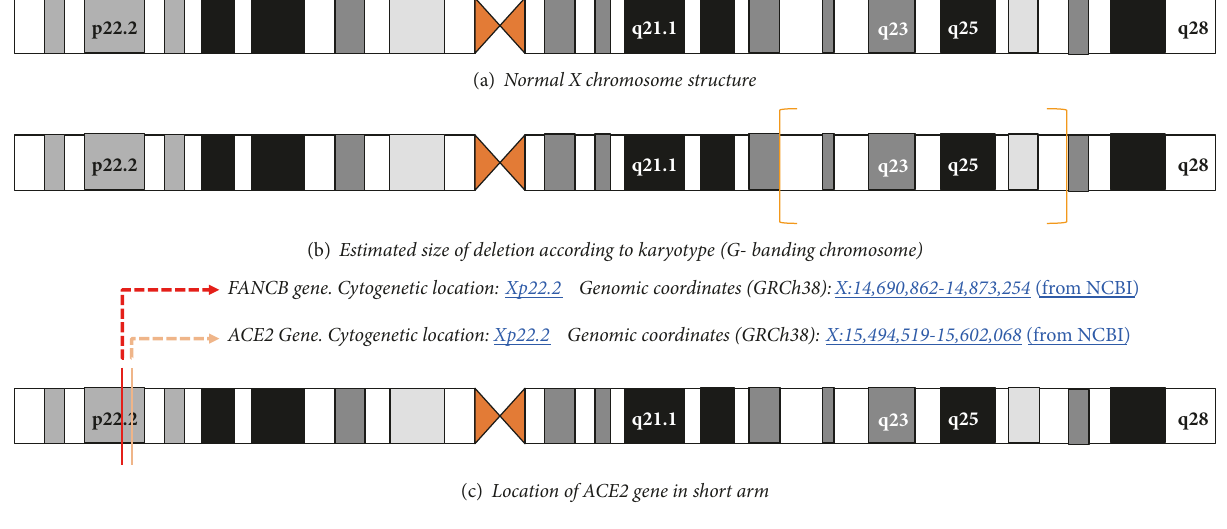
Figure 6: (a) X chromosome diagram. (b) In orange brackets, size of deletion in long arm of X chromosome is delimited. No aberrations in short arm were informed. (c) The location of different genes (FANCB and ACE2) is marked in diagram of X chromosome (short arm). Duplication informed by MLPA involves the entire PAR1 and spread until FANCB gene (red dashed arrow). ACE2 gene (blue dashed arrow) is located next to FANCB. The activity of ACE2 was measured by ELISA